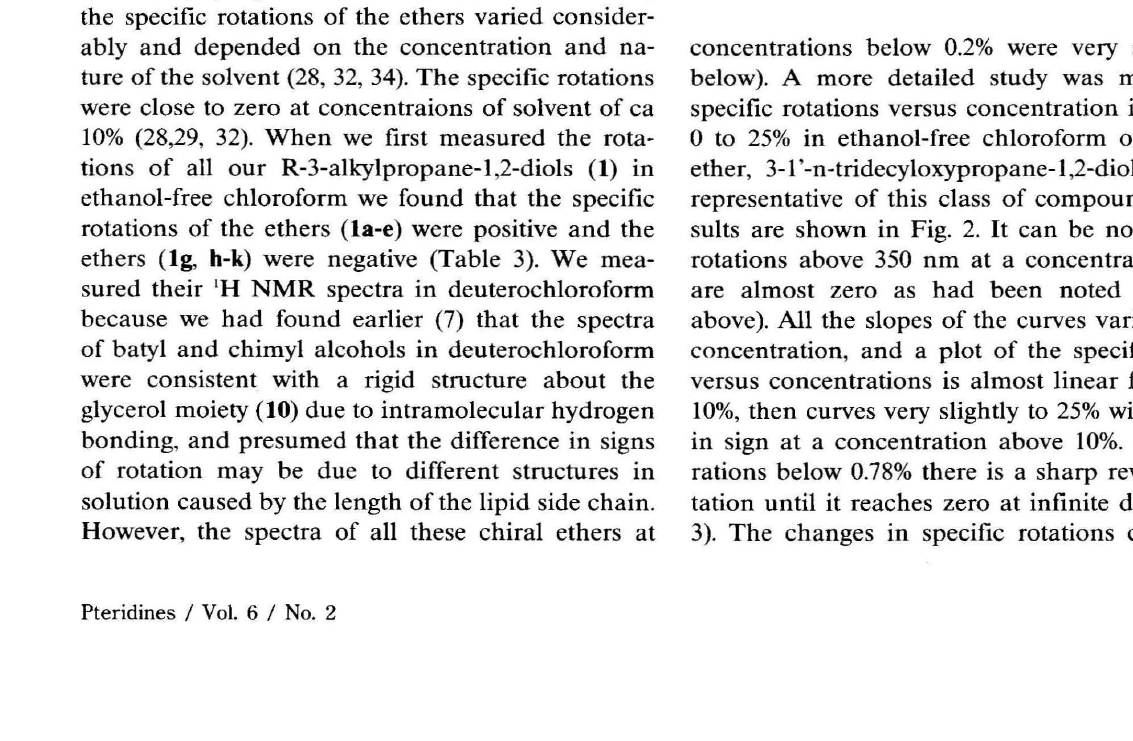
Figure 3. Effect of concentration on Specific